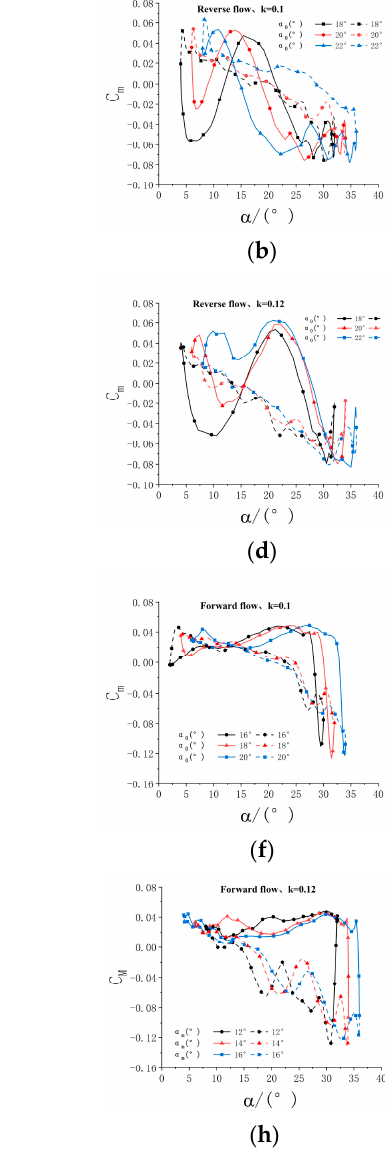
Table 6. Experimental conditions of changing the mean angle of pitch at different reduced frequen- cies.